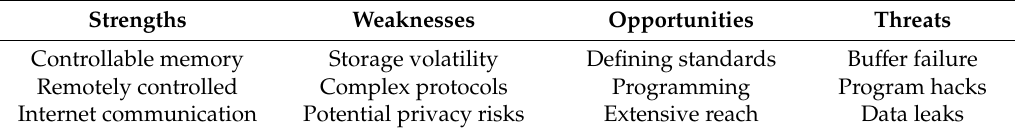
Table 4. SWOT analysis descriptors used in faults-and-vulnerabilities mapping of the application. Strengths